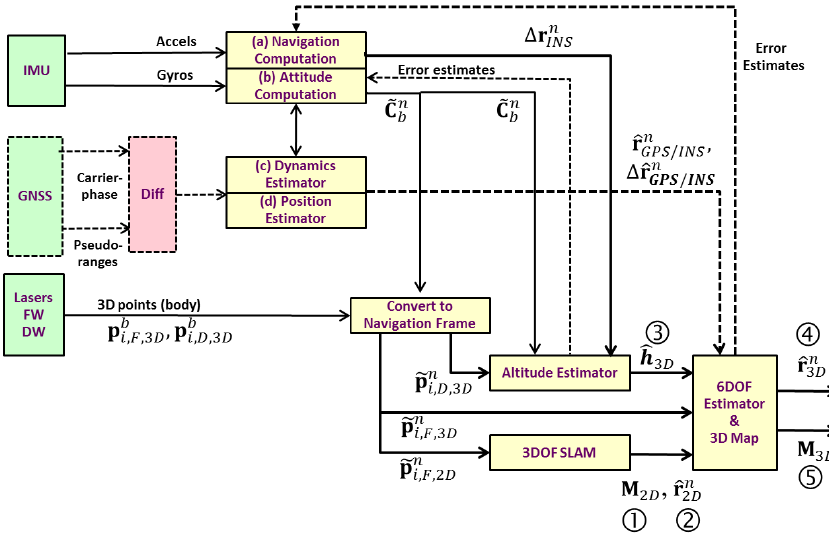
Figure 10. Integration strategy during indoor (mode 3) and transition (mode 2).